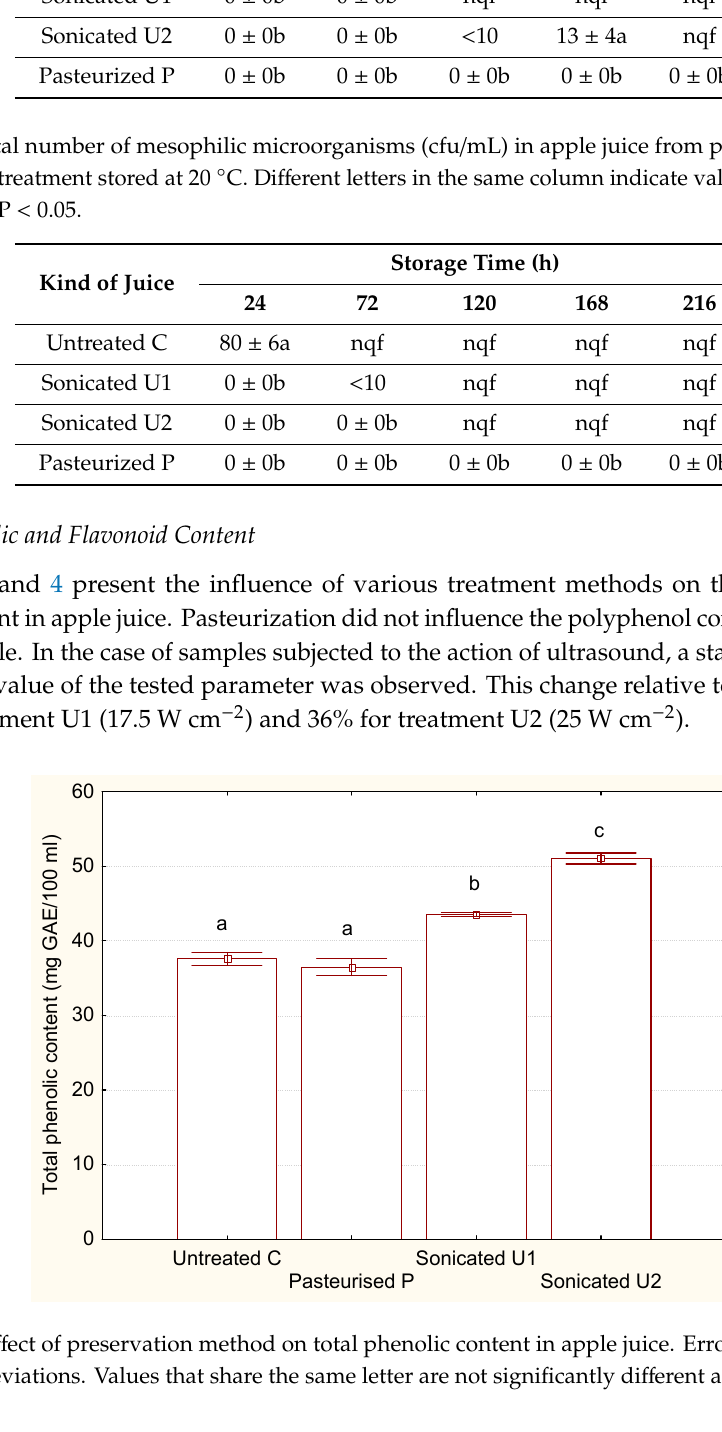
Table 4. Total number of mesophilic microorganisms (cfu/mL) in apple juice from piston press after ultrasound treatment stored at 20 °C. Different letters in the same column indicate values significantly different at P < 0.05.